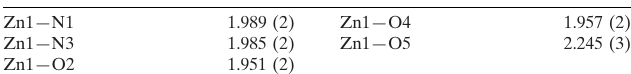
Selected bond lengths (A˚ ).